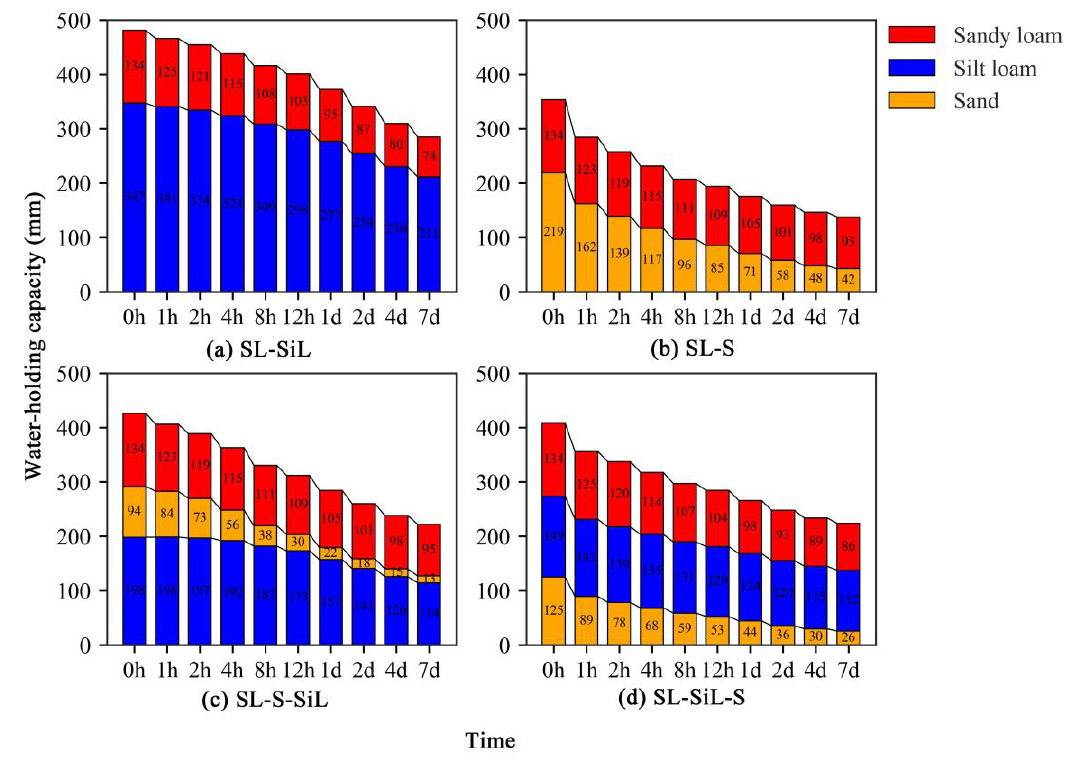
Figure 11. The actual water holding capacity of each layer at different times, (a) SL-SiL; (b) SL-S; (c) SL-S-SiL and (d) SL-SiL-S